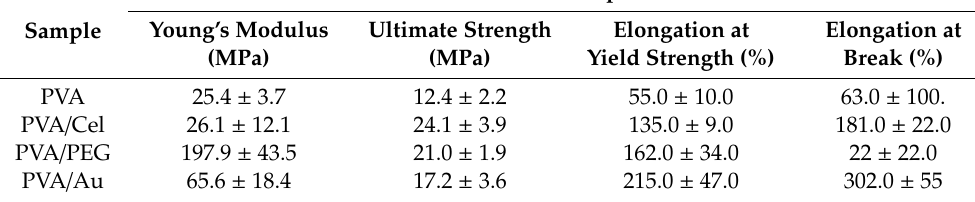
Table 4. Selected mechanical properties of the pristine PVA foils and of PVA foils doped with cellulose (PVACel), with poly(ethylene glycol) (PVA / PEG) or with Au nanoparticles in a PEG colloid solution (PVA / Au).